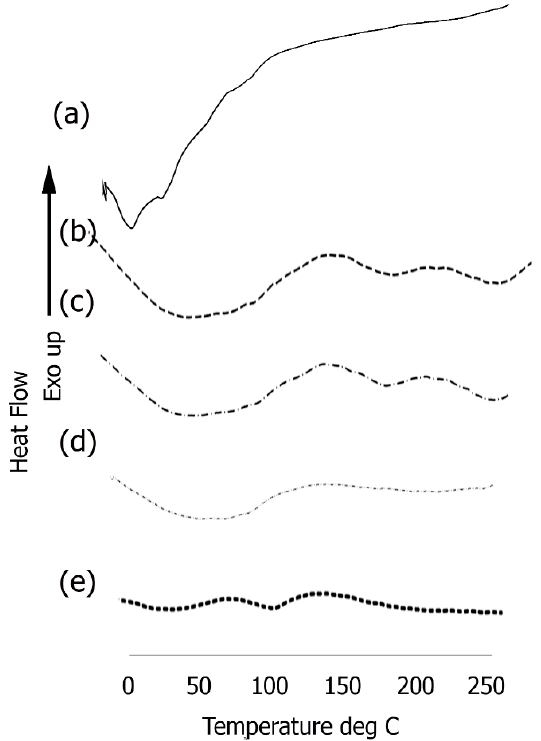
Figure 7. DSC thermograms of ( a ) self-assembled Ile-TMG-Ile nanoribbons; ( b ) Nanoribbons bound to laminin; ( c ) Artemin conjugated with laminin bound nanoribbons; ( d ) Type IV collagen conjugated with artemin-laminin bound nanoribbons; ( e ) PANI bound to Type IV collagen-artemin-laminin bound nanoribbons.